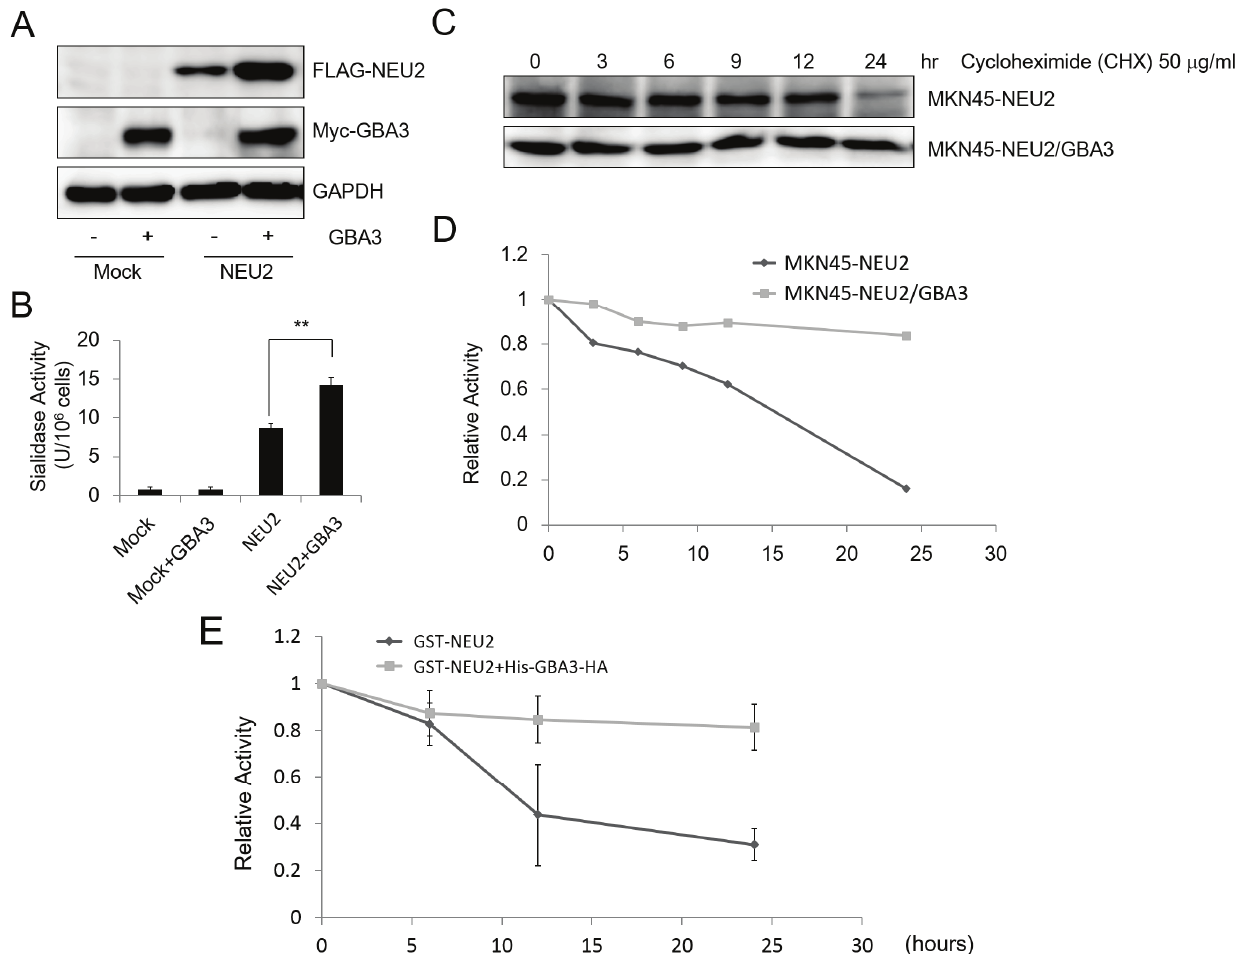
Figure 4. NEU2 was stabilized in the presence of GBA3. First, 1 (cid:4)g of pCMV-Myc-GBA3 as well as the mock vector (pCMV-Myc-N, Clontech) was transfected into 1 × 10 6 MKN45-Mock and MKN45-NEU2 cells. After a 48 h incubation, the cells were harvested, and were subjected to various analyses as follows: ( A ) western blotting for detection of NEU2 by anti-FLAG or GBA3 by anti-Myc antibody. GAPDH; as the loading control. ( B ) Sialidase (NEU2) activity assays of samples obtained in ( A) . **: p < 0.001. ( C ) Cycloheximide decay assay. Cycloheximide was added to the 1 × 10 6 of MKN45-NEU2 or MKN45-NEU2/GBA3 cells, and then cells were harvested at the indicated time points. Samples were analyzed by western blotting for analysis of NEU2 by anti-FLAG antibody. ( D ) Quantitation data for ( C ). The amount of protein at 0 time was set to 1. ( E ) Effect of GBA3 on the in vitro stability of NEU2. For this, 100 (cid:4)L of purified GST-NEU2 (1.5 mg/mL) mixed with recombinant 100 (cid:4)L of His-GBA3-HA (1.5 mg/mL) were incubated at 4 °C for the indicated times, and samples were subjected to a sialidase assay. For control incubation, 100 (cid:4)L of buffer (25 mM MES buffer containing 100 mM NaCl (pH 6.0)) was added to the 100 (cid:4)L of purified GST-NEU2. Activity of NEU2 at 0 time point was set to 1. Data shown represent data from three independent experiments. Error bars represent the ±